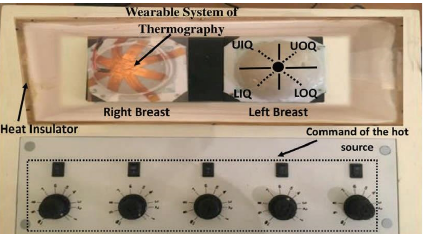
Figure 9: Experimental bench for the evaluation of THBC.